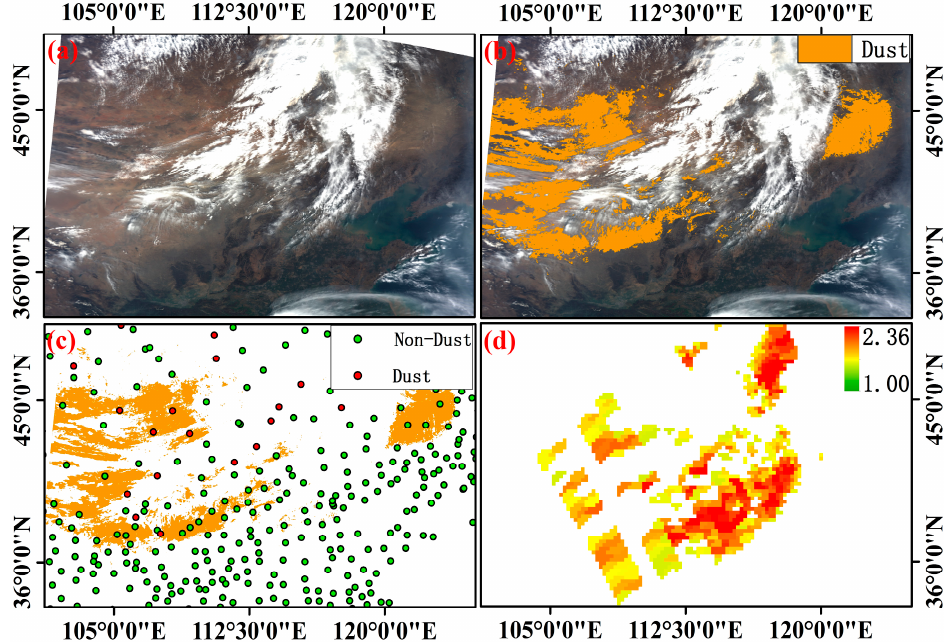
Figure 5. Comparison between the dust storm monitoring result ( b ), MODIS RGB image ( a ), MICAPS data ( c ), and OMI AI data ( d ) on 15 April, 2015.